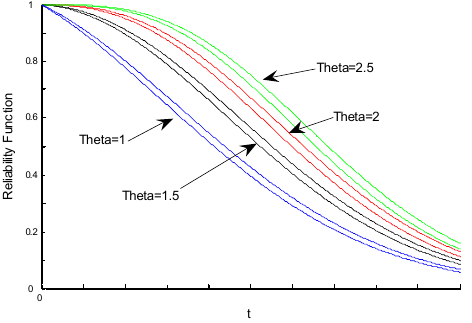
Fig. 3.  cut of fuzzy survival ( 0  ) for different